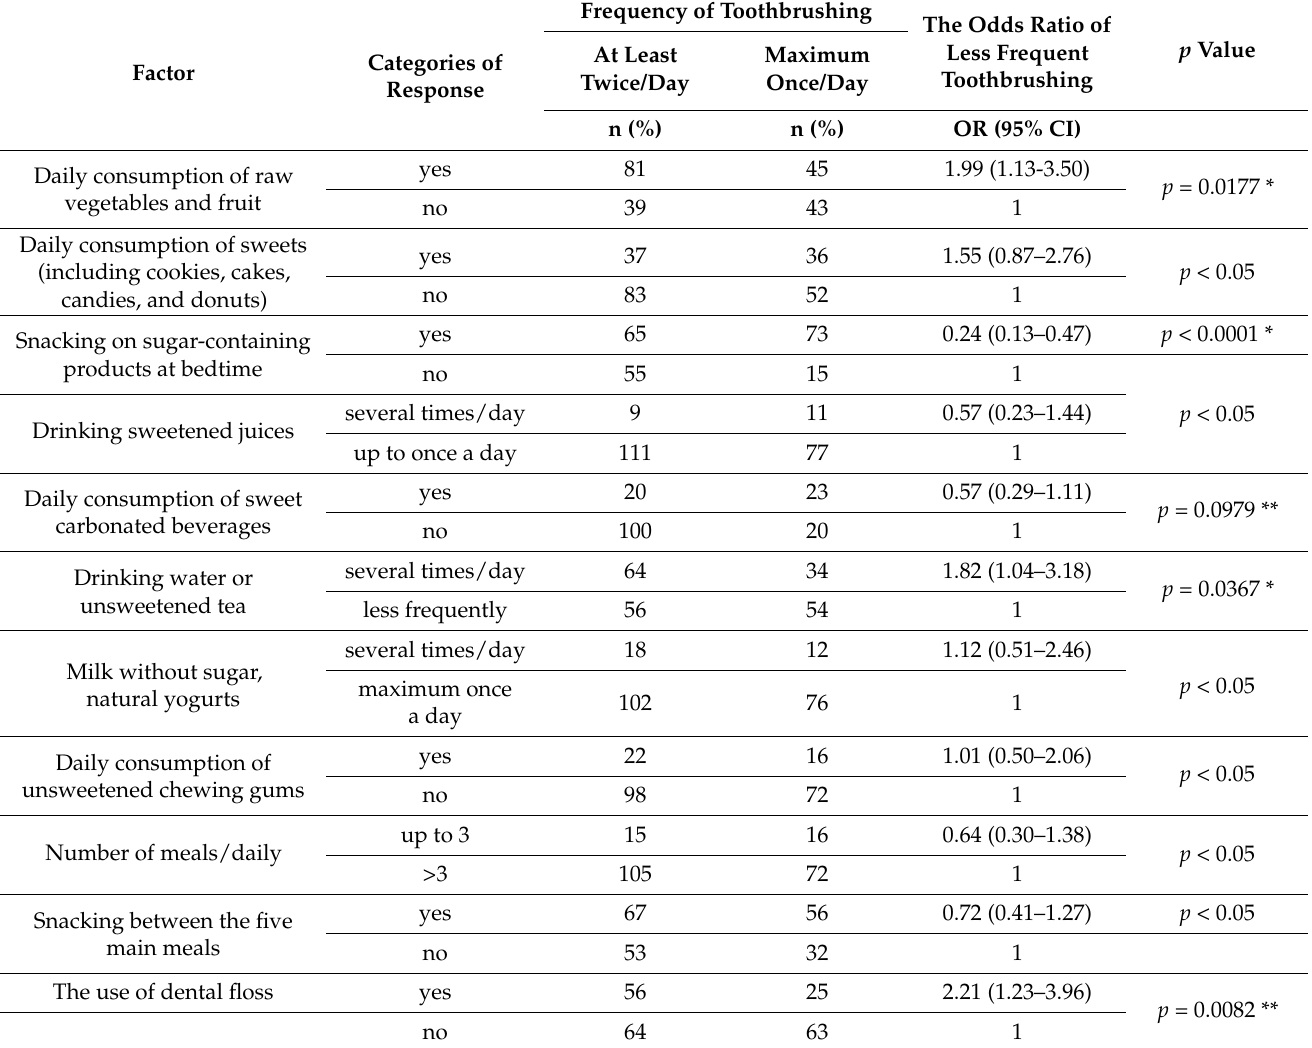
Table 6. The association between oral hygiene and dietary habits in the examined